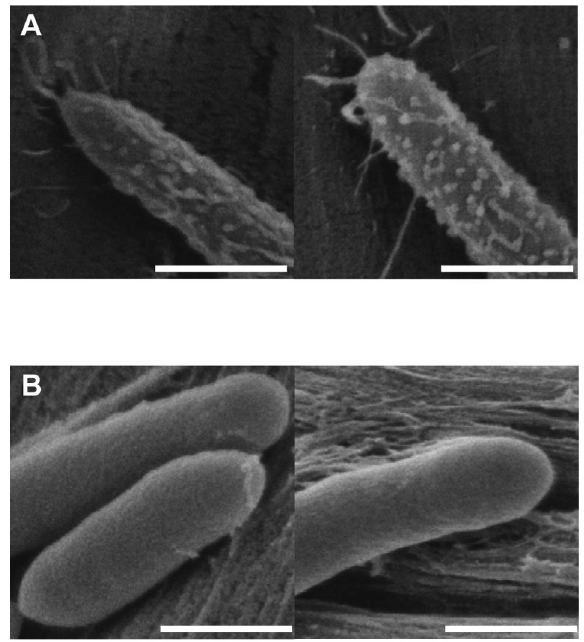
Figure 7. SEM observation of Clostridium cellulolyticum and Clostridium thermocellum grown on filter paper. Clostridium thermocellum (A) and Clostridium cellulolyticum (B) were grown on filter paper. Pictures are representative of two independent experiments. Bar represents 500 nm.